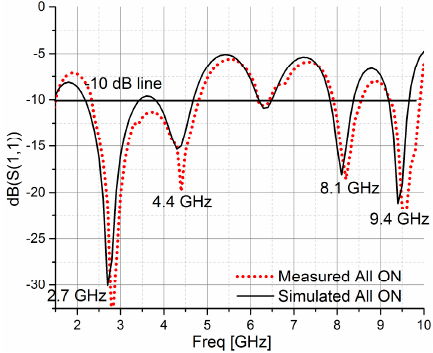
Figure 9. Measured and simulated S 11 for all switches ON.